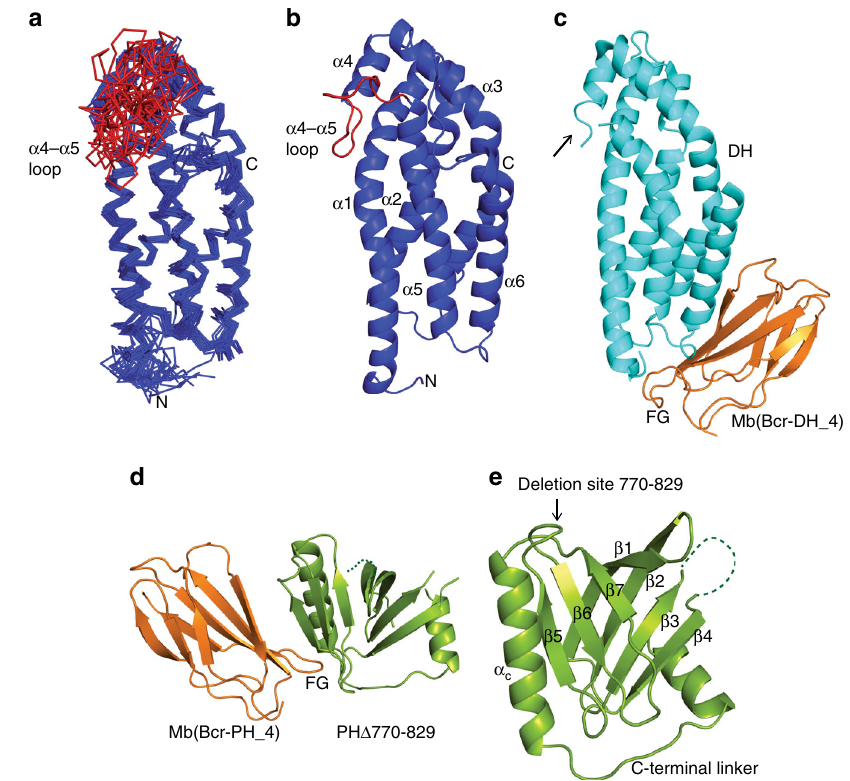
Fig. 2 Structures of the DH and PH domains by NMR and X-ray crystallography. a Bundle of 20 DH structures as determined by NMR spectroscopy. The long and fl exible α 4 – α 5 loop region (residues 622 – 638) is highlighted in red. b Cartoon representation of the NMR conformer closest to the mean. The six helical elements and the α 4 – α 5 loop region are labeled. c Crystal structure of the DH domain in complex with Mb(Bcr-DH_4) in cartoon representation. The α 4 – α 5 loop region is missing in this structure (black arrow). The monobody interacts with the DH domain via its FG loop, which is labeled. d Crystal structure of the internally deleted PH domain (PH Δ 770 – 829) in complex with Mb(Bcr-PH_4) in cartoon representation. The monobody interacts with the PH domain via its FG loop, which is labeled. e Cartoon representation of the PH domain (PH Δ 770 – 829) with assignment of the secondary structure elements, the internal deletion site covering residues 770 – 829 and the C-terminal linker